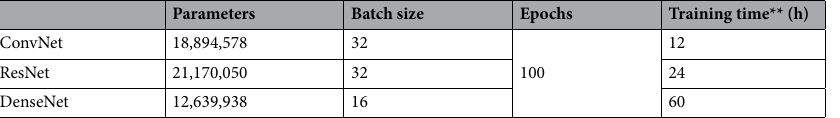
Table 2. Model training statistics. **Using Intel(R) Core(TM) i7-8750H CPU processor with 16GB Ram and NVIDIA GeForce GTX 1070 with Max-Q Design